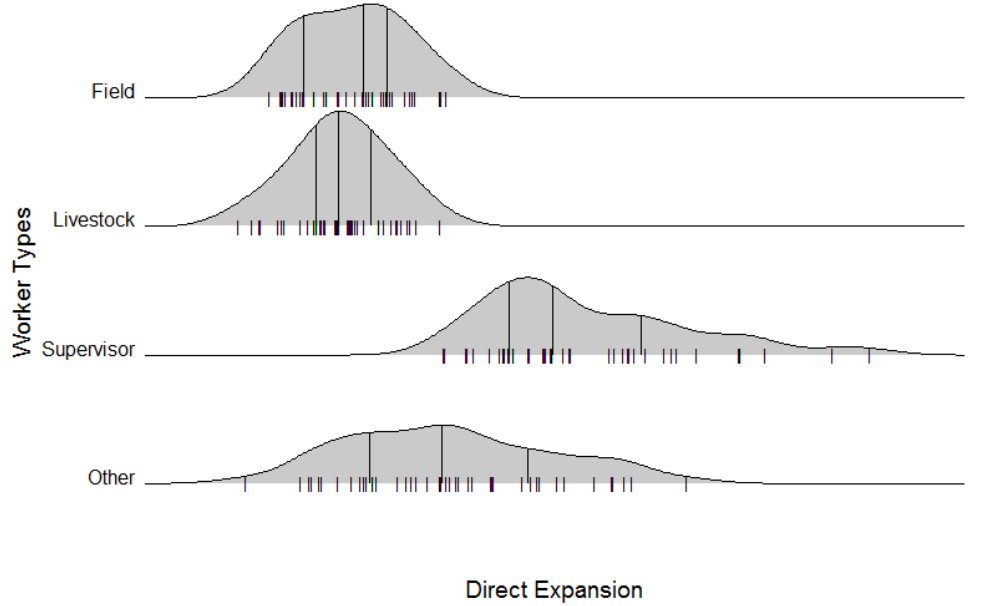
Figure 4. Density plots of the original January 2020 state-level survey estimates of wage rates (USD/hour) by worker type: field workers, livestock workers, supervisors, and other types of